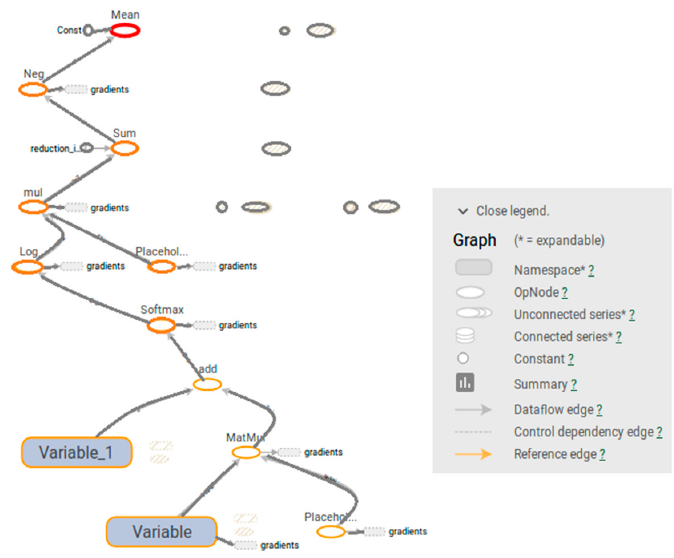
Figure 4. Learning and entropy minimization structure.